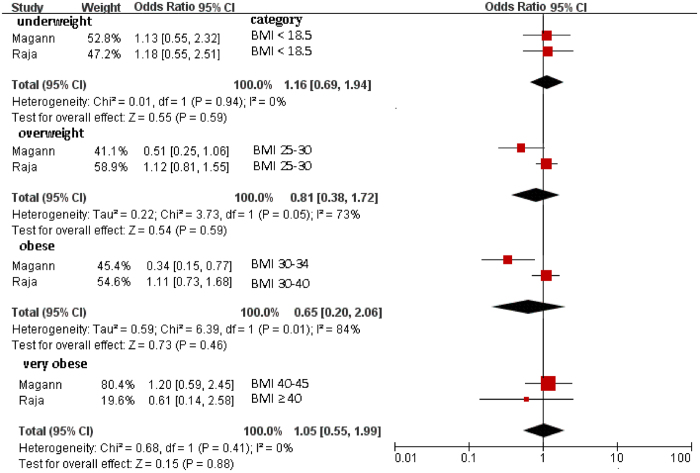
Forest plot of pooled analyses of maternal BMI categories and cord pH < 7.1.Maternal BMI in different categories showed nonsignificant associations with cord pH < 7.1. Note that ORs are for each category as compared with the “normal weight” category (BMI 18–25).